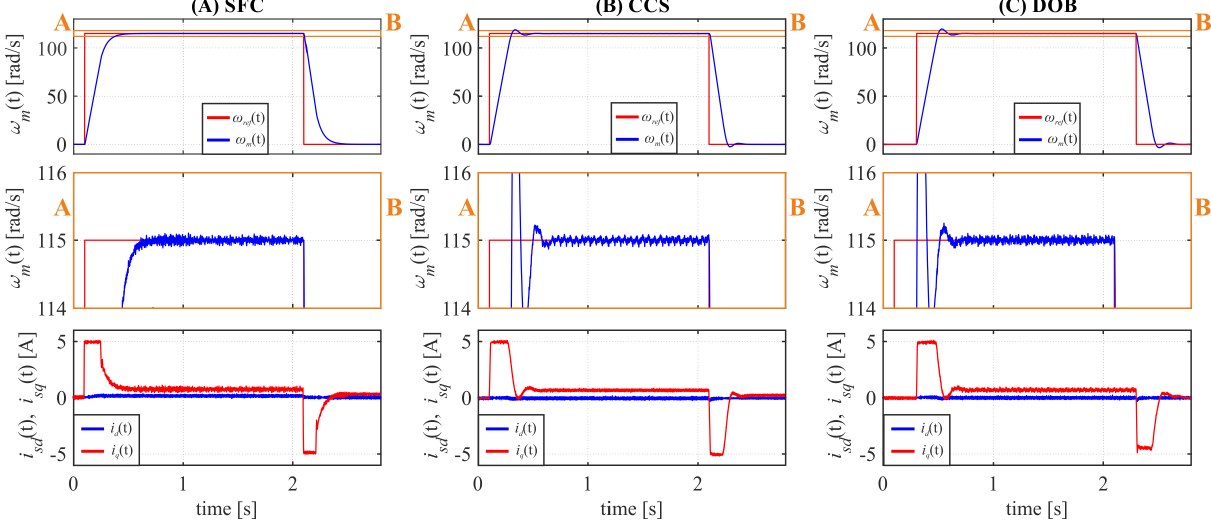
Figure 16. Step response of the investigated control structures for the reference signal of 115 rad/s without